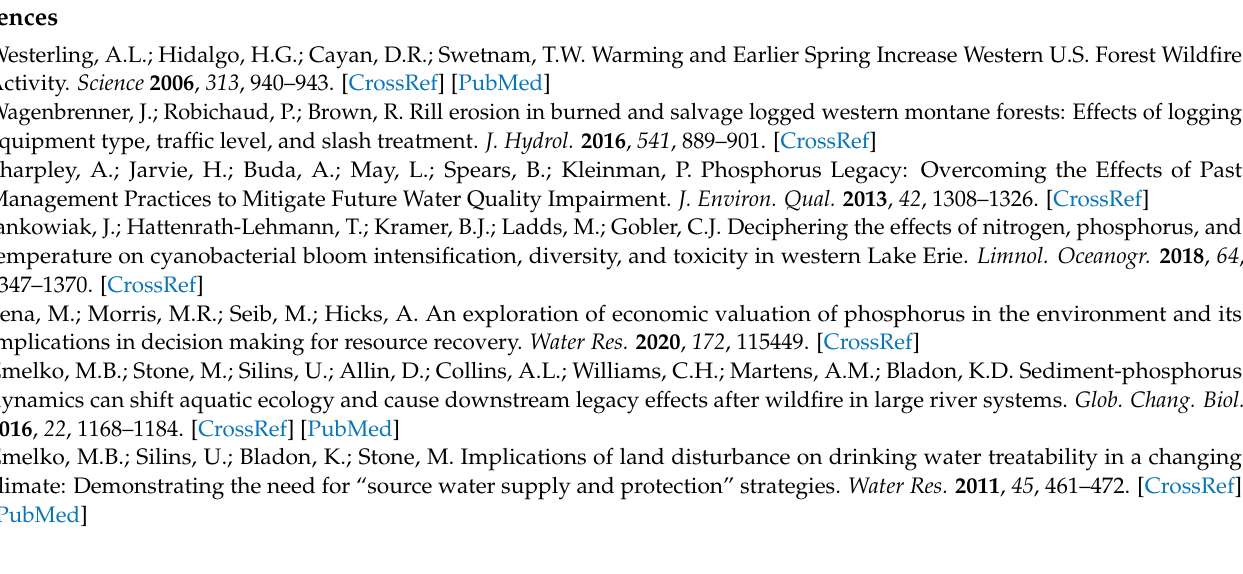
Supplementary Materials: The following are available online at https://www.mdpi.com/article/ 10.3390/w13223151/s1, Figure S1: Average proportion of particulate phosphorus (PP) forms in Table S1: p-values for post-hoc pairwise Mann-Whitney rank sum tests between sites for riverbed fine sediment Al2O3 proportions, Table S2: p-values for post-hoc pairwise Mann-Whitney rank sum tests between sites for riverbed fine sediment Fe2O3 proportions, Table S3: p-values for post-hoc pairwise Mann-Whitney rank sum tests between sites for riverbed fine sediment MnO